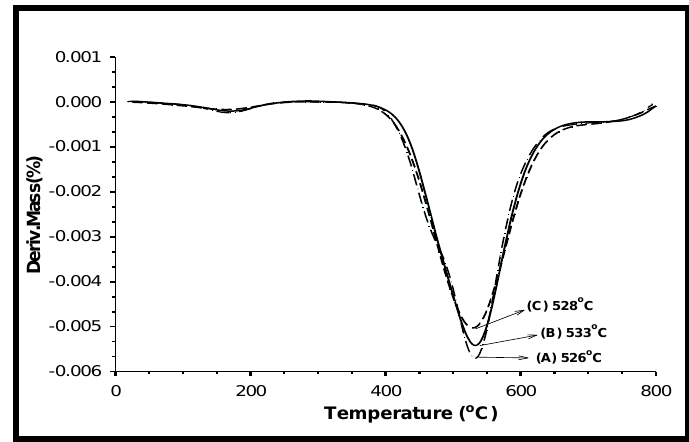
Figure 15. DTGA: Ar pure ( A ); Ar-CNT-C ( B ) and Ar-CNT-P ( C ) composites with 5 wt % CNT.